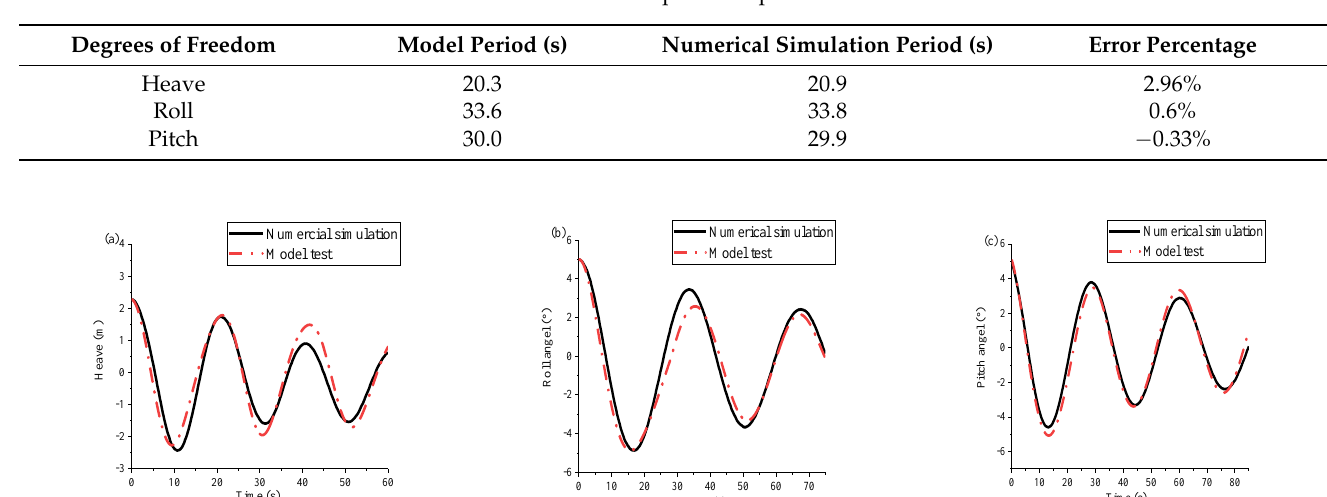
Table 7. Natural period of platform.